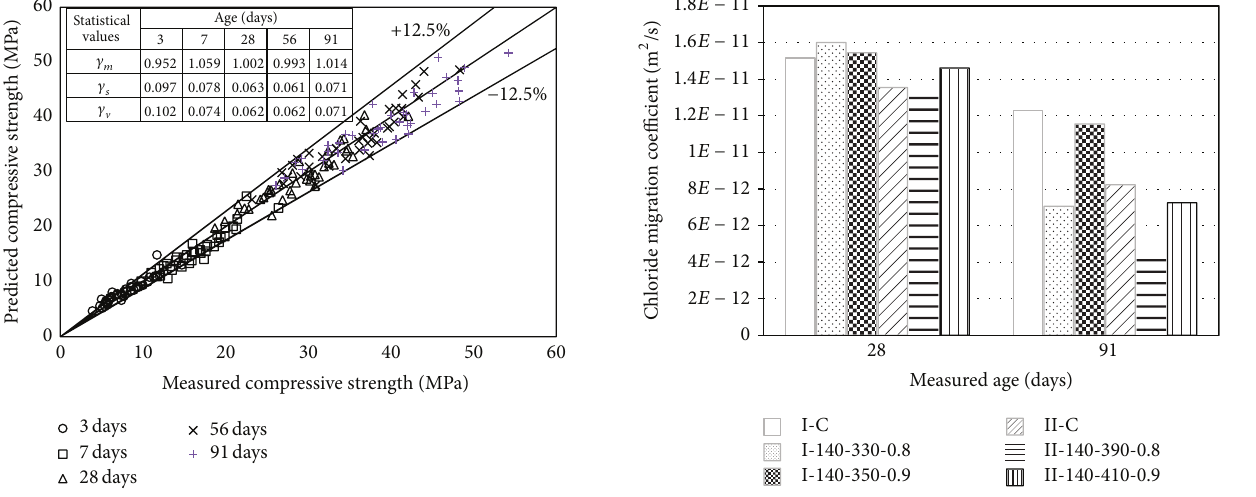
Figure 7: Comparison of predicted and measured strengths at different ages.